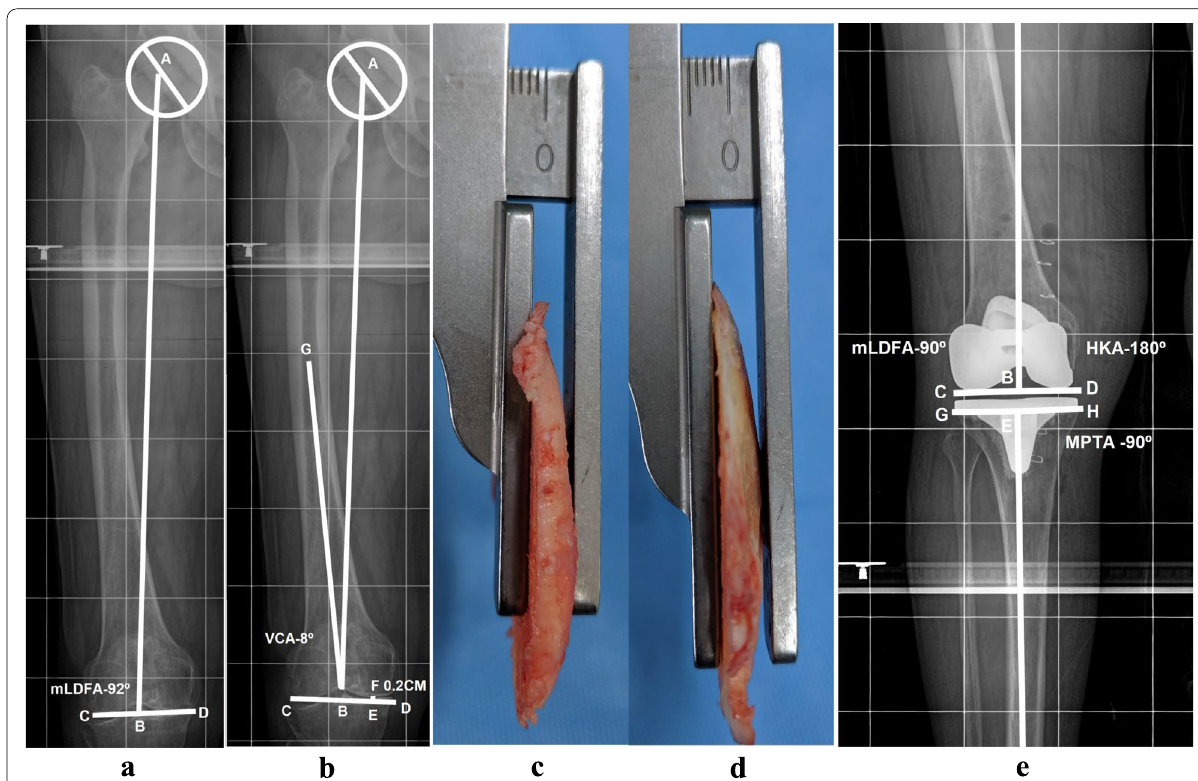
Fig. 2 a Depicting the mechanical axis of femur (Line AB), and a tangential line to the distal femoral articular surface (Line CD) and preoperative mLDFA (angle ABC), 92 ° that means 2 ° varus correction in femur is required. b Depicting the femoral mechanical axis (Line AB), and a line perpendicular to mechanical axis, a line tangential to at least one distal femoral condyle, and in this case lateral distal femoral condyle, (Line CD). Line CD is 0.2 cms away from medial femoral condyle, meaning bone cut from medial femoral condyle must be 0.2 cm less than lateral femoral condyle. Line GB is trajectory for intramedullary road and this line makes 82 ° angle (angle GBC), which means VCA of 8 ° . c Intra-operative photograph showing thickness of the bone resected from the medial femoral condyle, 4.5 mm. d Intra-operative photograph showing the thickness of the bone resected from the lateral femoral condyle, 6 mm (planned difference of thickness of bone resection from medial and lateral femoral condyle was 2 mm, here we could get 1.5 mm difference). e Post-operative LLR (showing only knee). Depicting the mLDFA, angle ABC, 90